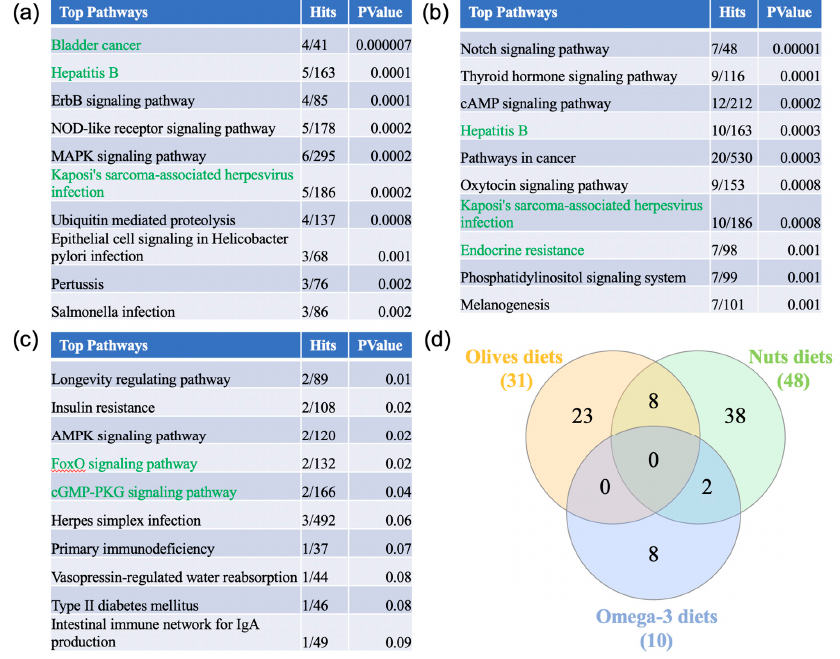
Figure 3. Pathway analysis. ( a – c ) The genes differentially expressed in 2 out of 3 olive supplement arrays, in the nuts supplement array, in at least 2 out of the 4 arrays from fish or EPA + DHA diets were obtained using Venn analysis. The gene lists were uploaded to https://www.networkanalyst.ca/NetworkAnalyst/faces/home.xhtml, where a list enrichment network analysis was performed using the KEGG database. The 10 tops pathways identified from the olive-, nuts-, or omega-3-supplemented diets are listed in ( a ), ( b ), and ( c ) respectively. ( d ) The pathways shared between the three types of Mediterranean diets were analyzed in a Venn diagram